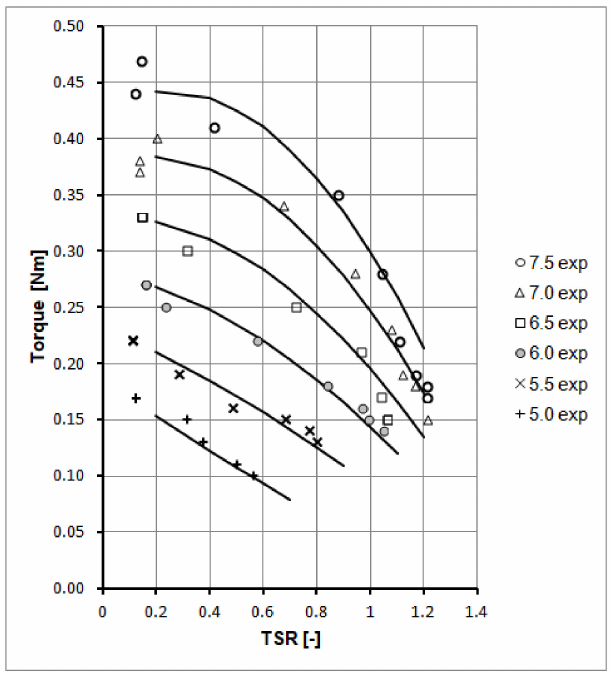
Figure 13. Comparison of measurements with approximation of characteristics (Equation (11)) for four-segment